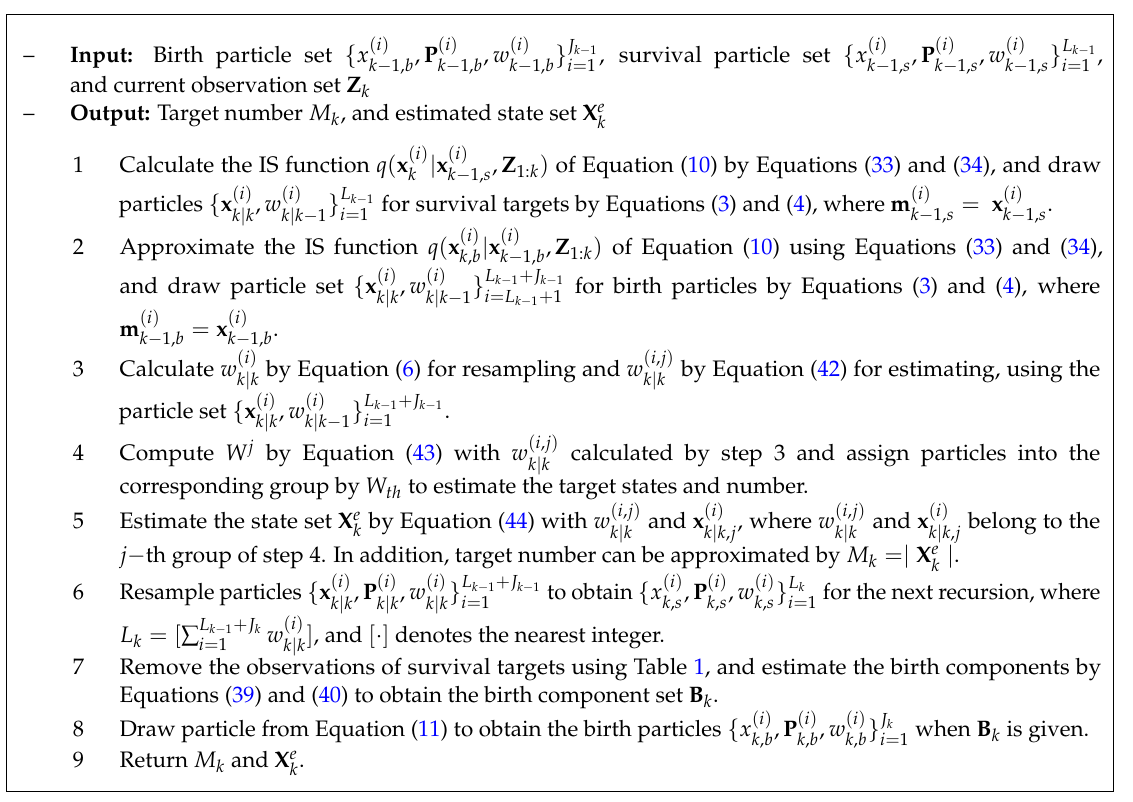
Table 2. The CISMC-PHD filter at time k .